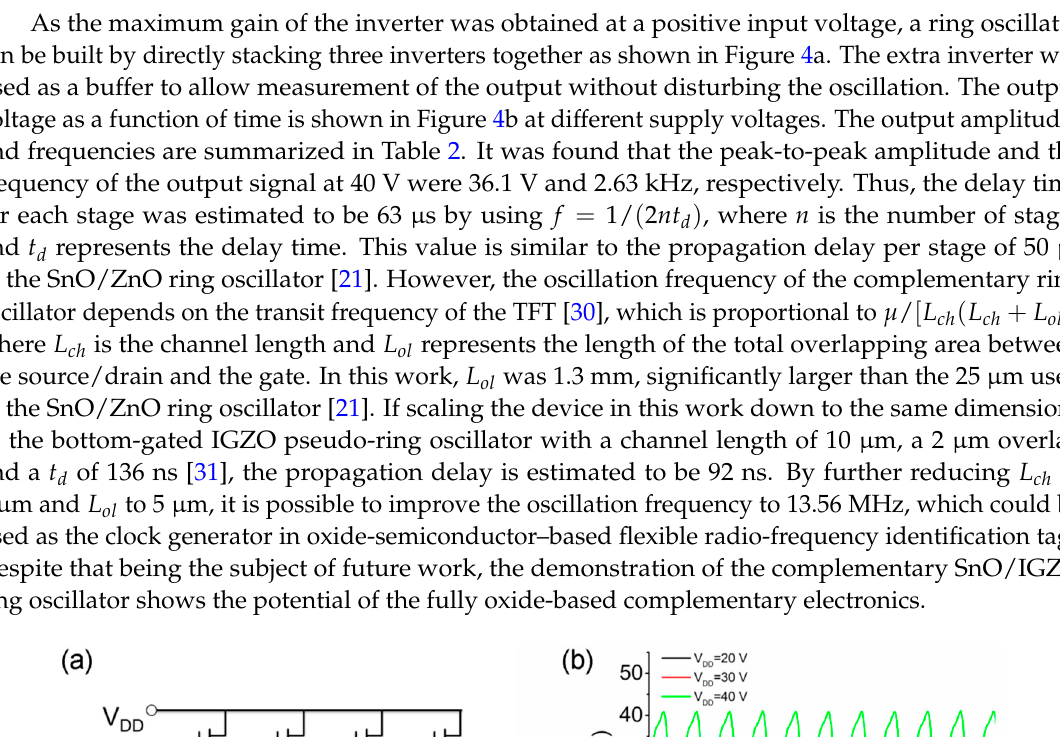
Figure 3. ( a ) Output voltage and ( b ) gain of the complementary inverter as a function of input voltage at different V DD .